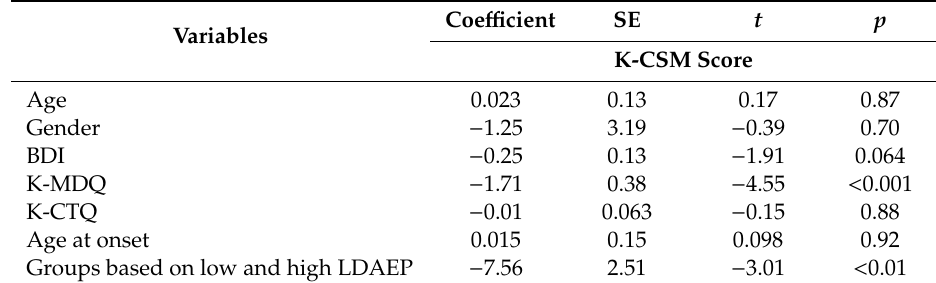
Table 3. Results of multiple linear regression analysis for the association between K-CSM scores and clinical